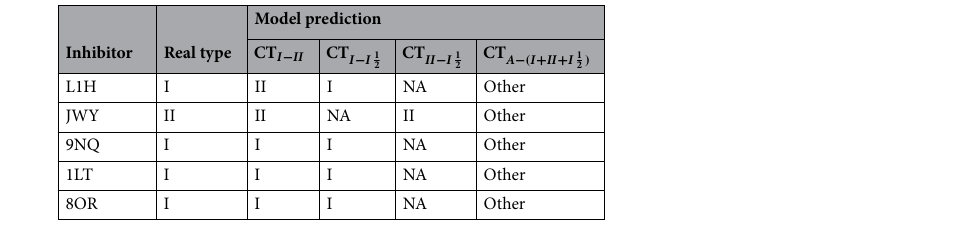
Table 5. Results for predicting case study